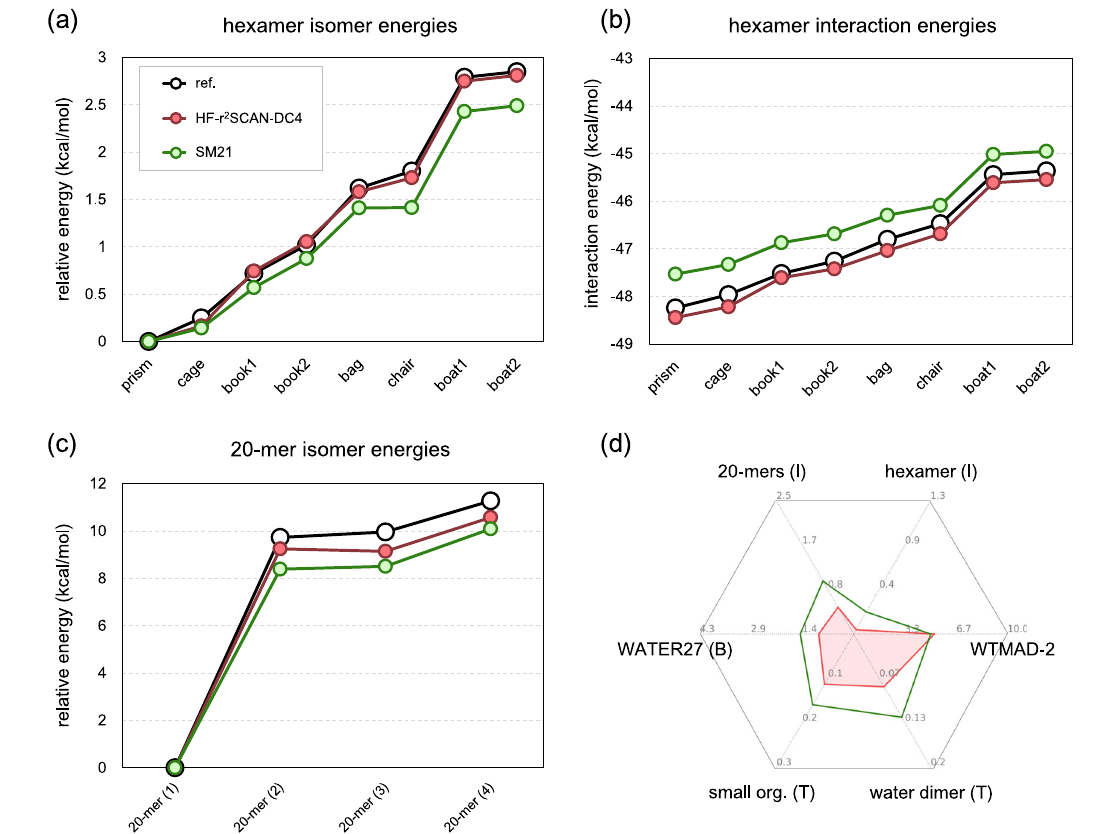
Fig. 6 | Comparison between HF-r 2 SCAN-DC4 and SM21. a Water hexamer isomerization energy, b water hexamer interaction energy, c water 20-mer isomerization energy, and d hexgonal plot same as Fig. 5b. SM21 (green) is HF-r 2 SCAN but with different D4 parameters obtained in ref. 64